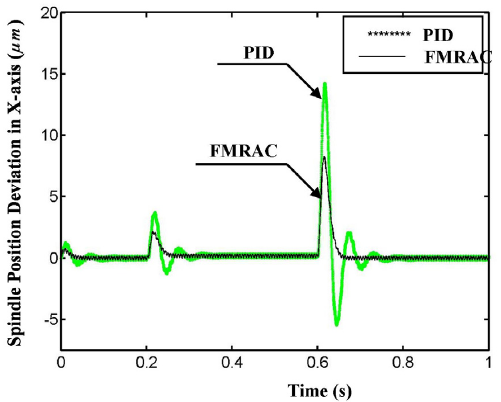
Figure 13. Spindle position deviation in the X -axis under various control laws.